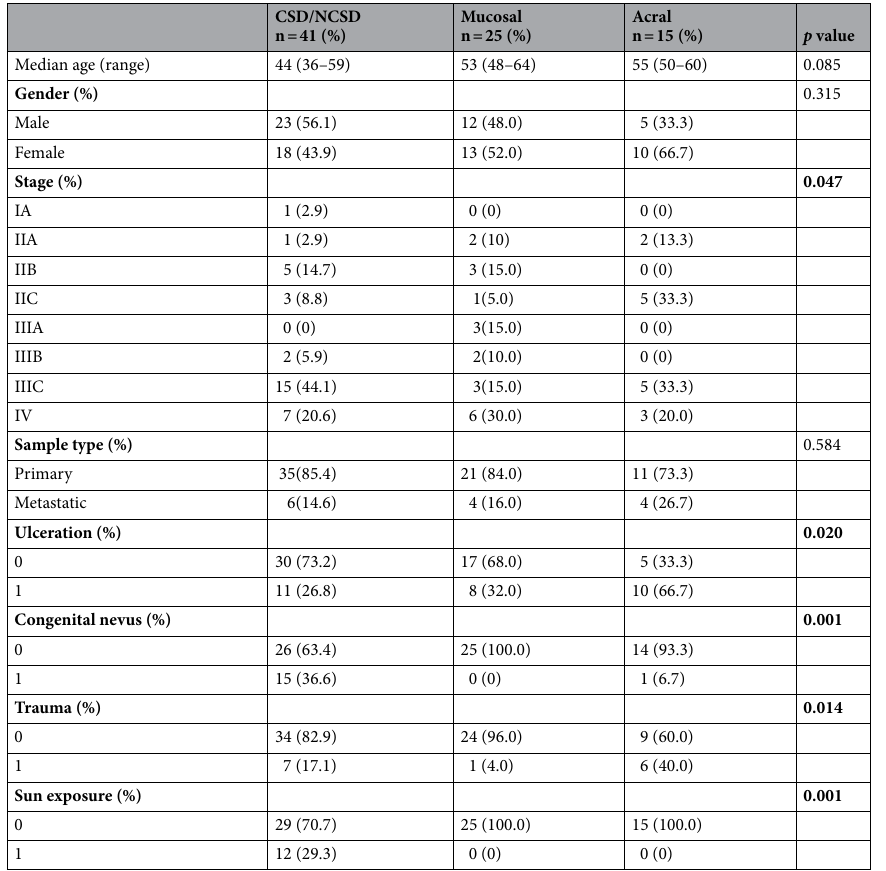
Table 1. Clinicopathological characteristics. * P values < 0.05 in bold are statistically